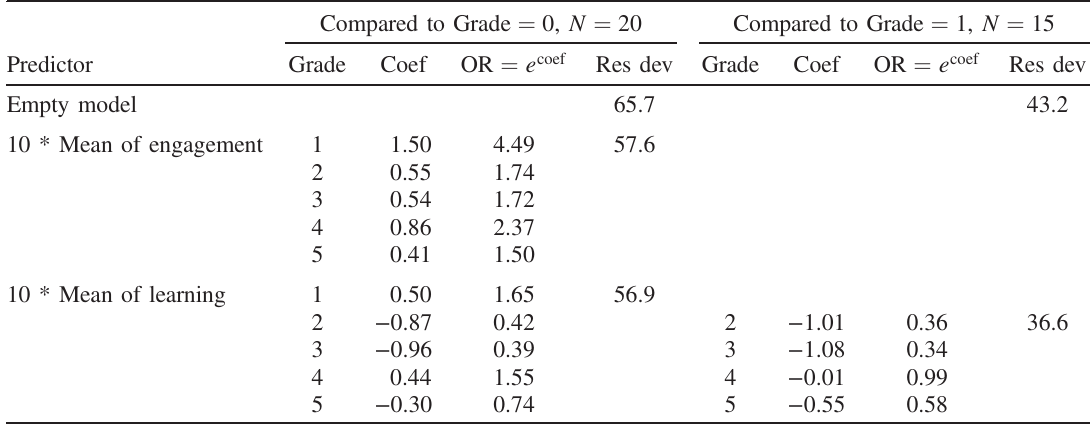
TABLE VII. Results of multinomial logistic regressions for models with substantial support, when the outcome was grade of Math2.